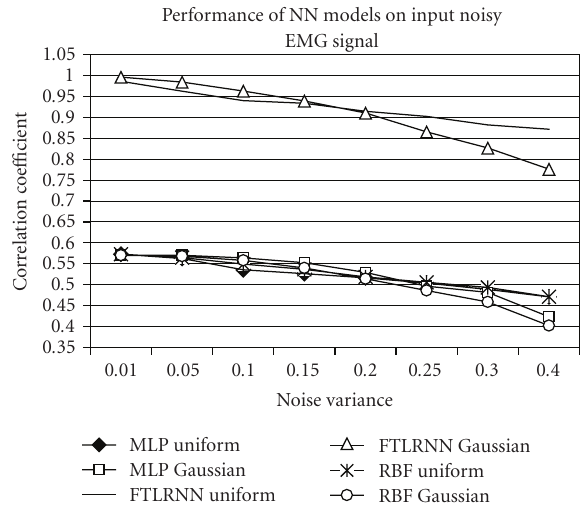
Figure 16: E ff ect of noise on EMG